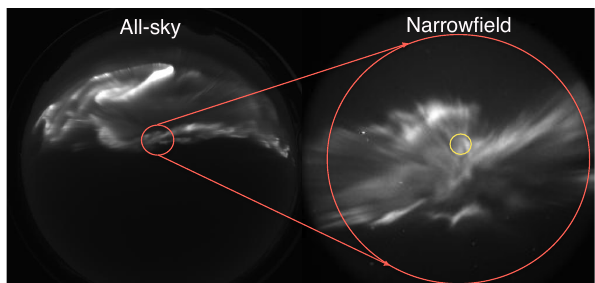
NarrowfieldAll-sky Figure 3. Event 1: all-sky image (left) – taken with 557.7nm filter – and narrow-field image (right) – taken with a BG3 filter – show- ing the dynamic structured aurora at the time of the NEIALs in the PFISR data. The yellow circle near the center of the narrow-field image represents the location of the PFISR radar beam in the mag- netic zenith. North is down and east is to the right.